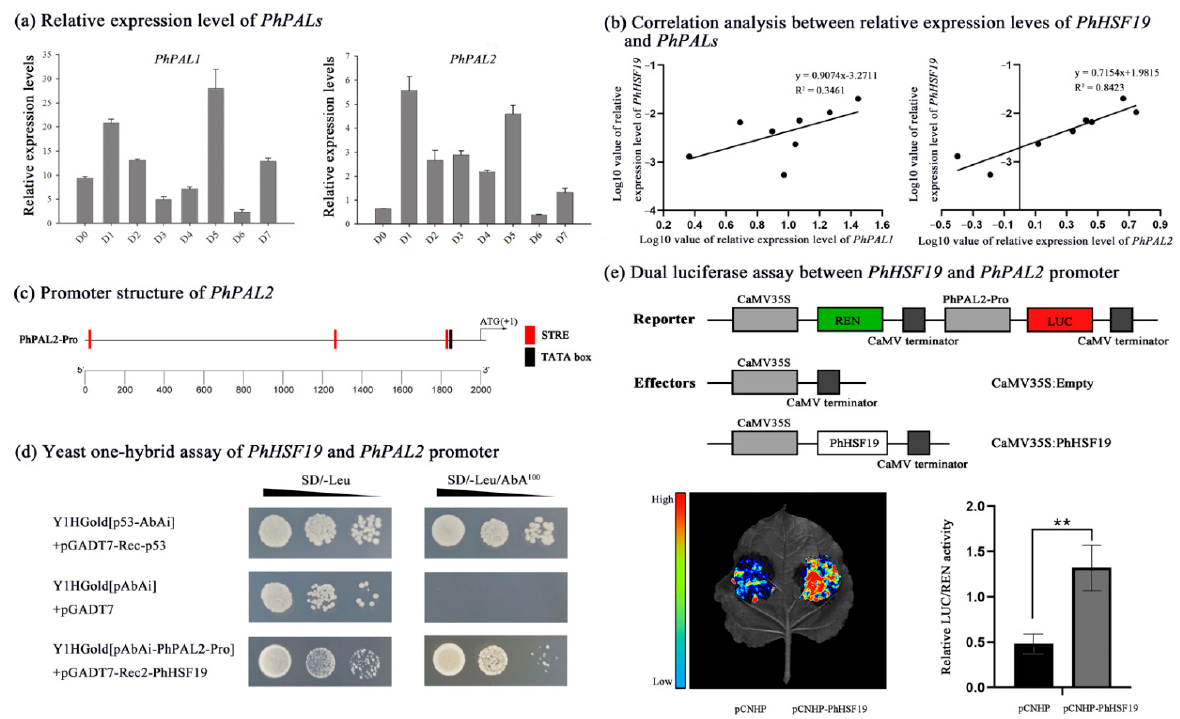
Figure 6. PhHSF19 could bind to the PhPAL2 promoter. ( a ) Relative expression level of PhPAL1 and PhPAL2 during flower opening. ( b ) Correlation analysis between the relative expression of PhHSF19 and PhPAL1 / PhPAL2 . ( c ) Location of the STRE cis -element in the PhPAL2 promoter. ( d ) Yeast one- hybrid assays of the PhHSF19 and PhPAL2 promoters. ( e ) Dual luciferase assay between the PhHSF19 and PhPAL2 promoter, including the schematic diagram of the double-reporter and effector plasmids, qualitative results, and quantitative results. T-test was used for statistical analyses of quantitative results compared with corresponding control (**, p < 0.01).